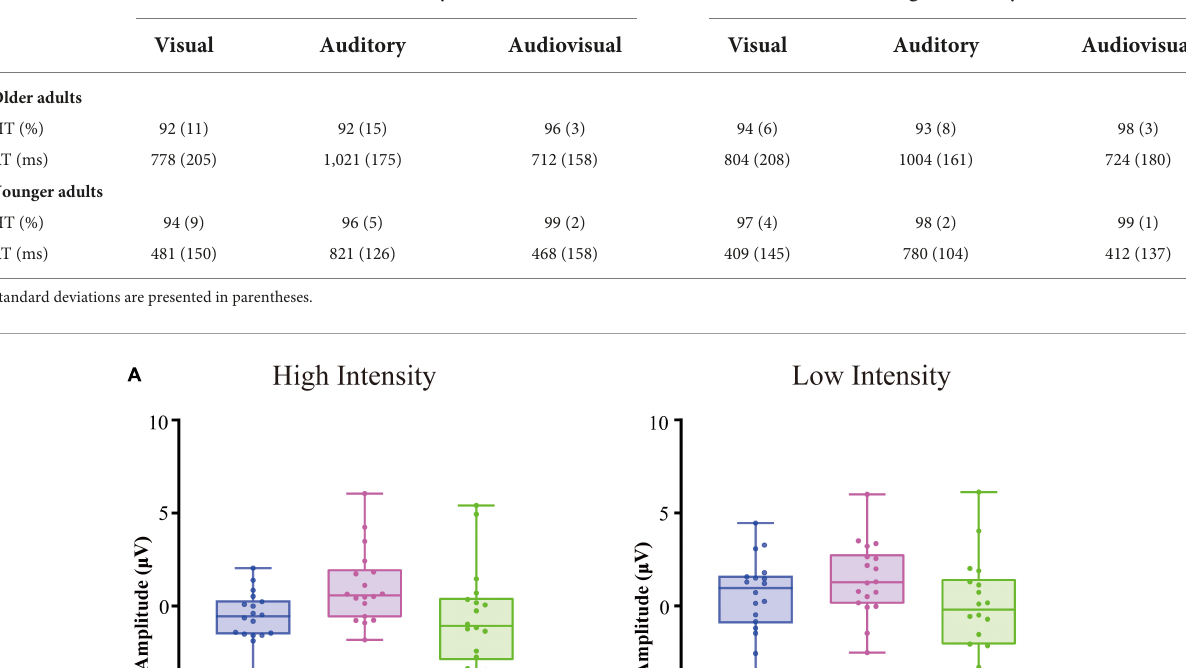
occipital regions ( M = − 1.37 µ V, SE = 0.35 µ V); additionally, the amplitude of fronto-central ( M = − 3.14 µ V, SE = 0.79 µ V) and centro-parietal ( M = − 2.56 µ V, SE = 0.49 µ V) regions